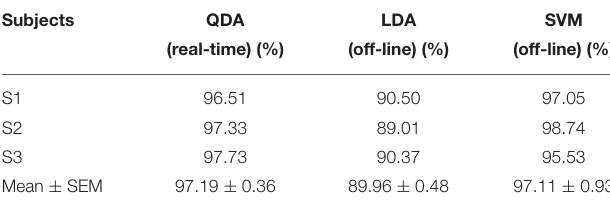
TABLE 2 | Recognition accuracy (mean ± SEM) based on QDA, LDA, and SVM.